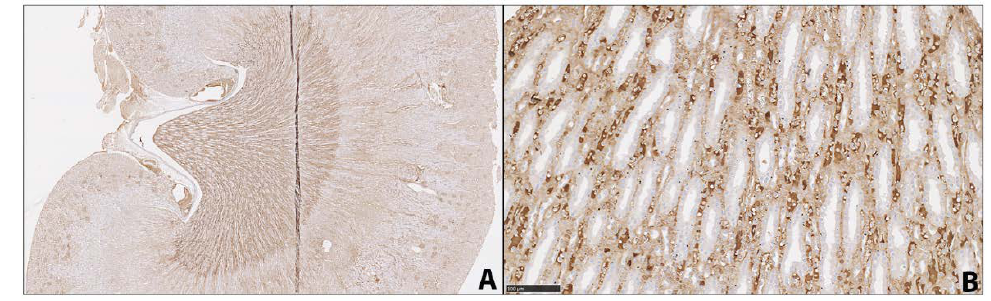
Figure 2. p-S6 staining in AA treated kidneys. A , AA I treated kidneys showing staining for p-S6 protein principally in the papilla, contrasting with Experiment 1; B , detail in papilla (bar 100 μm).